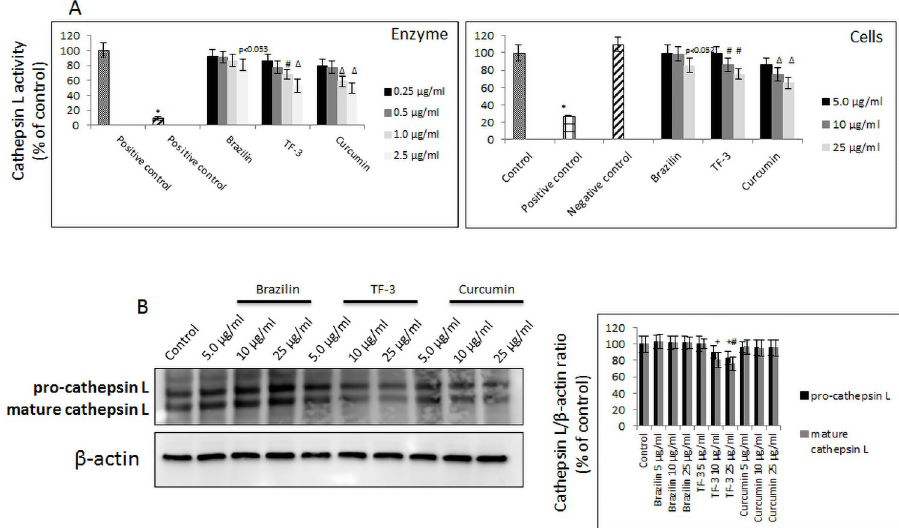
Fig 6. Effect of selected polyphenols on cathepsin L. (A) Activity of purified cathepsin L enzyme upon treatment with indicated polyphenols at different concentrations (left panel). Activity of cellular cathepsin L upon treatment with indicated polyphenols at different concentrations (right panel). Data are presented as % of control ± SD; Δ p � 0.01, � p � 0.001, + p < 0.054. Control– 0.025% DMSO, positive control– 0.1 μ M E-64. (B) Western blot analysis of cathepsin L expression in A549 cells treated with indicated polyphenols with different concentration for 24h. (left panel) and quantified as band densitometry analysis indicating changes in protein expression (right panel). Data are presented as % of control ± SD; control– 0.025% DMSO, TF-3 –theaflavin-3,3’-digallate.